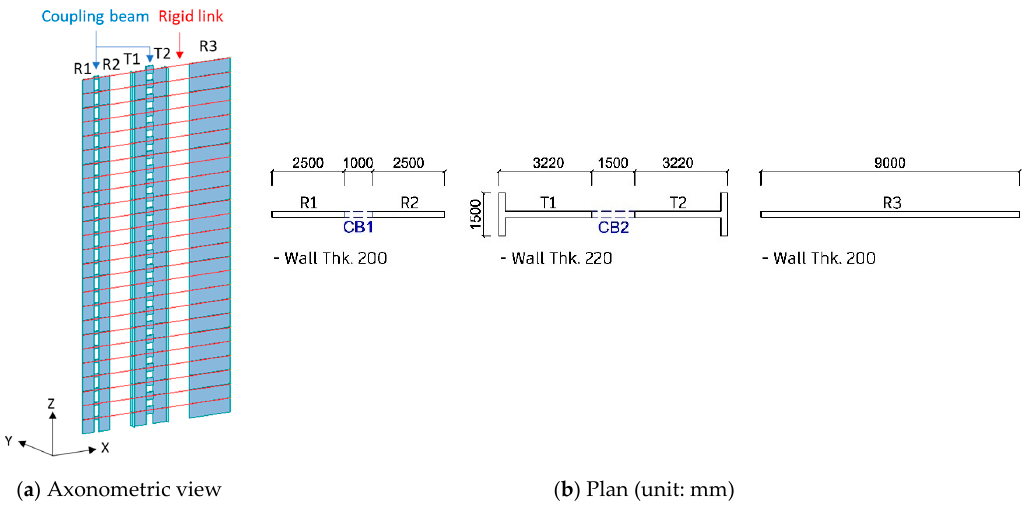
Figure 1. Configuration of Model A. Table 1. Characteristics of analysis model.